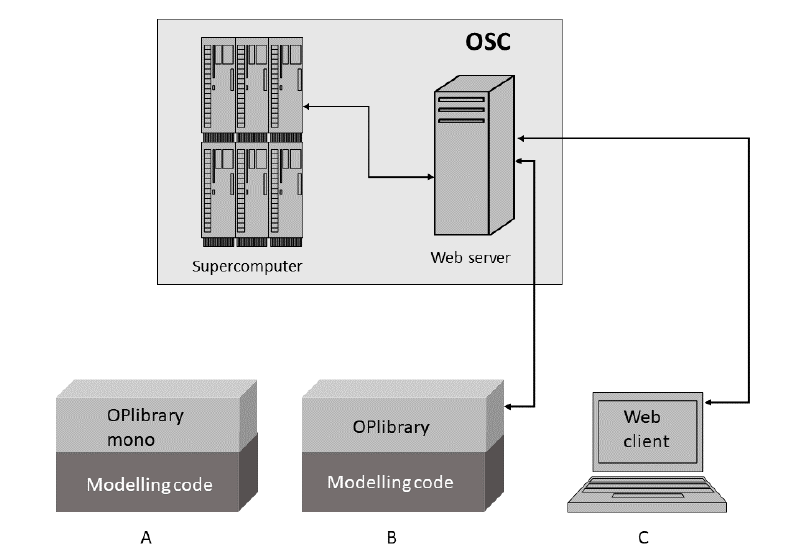
Figure 4. OPserver data-service model based at the Ohio Supercomputer Center (OSC) showing its three access modes: ( A ) Local mode where the OPlibrary and monochromatic opacities ( mono ) are downloaded and linked to a modeling code; ( B ) Cloud model where the OPlibrary is downloaded locally and linked to the modeling code but mono is accessed remotely from the OSC; and ( C ): web-page mode. Reproduced from Figure 2 of